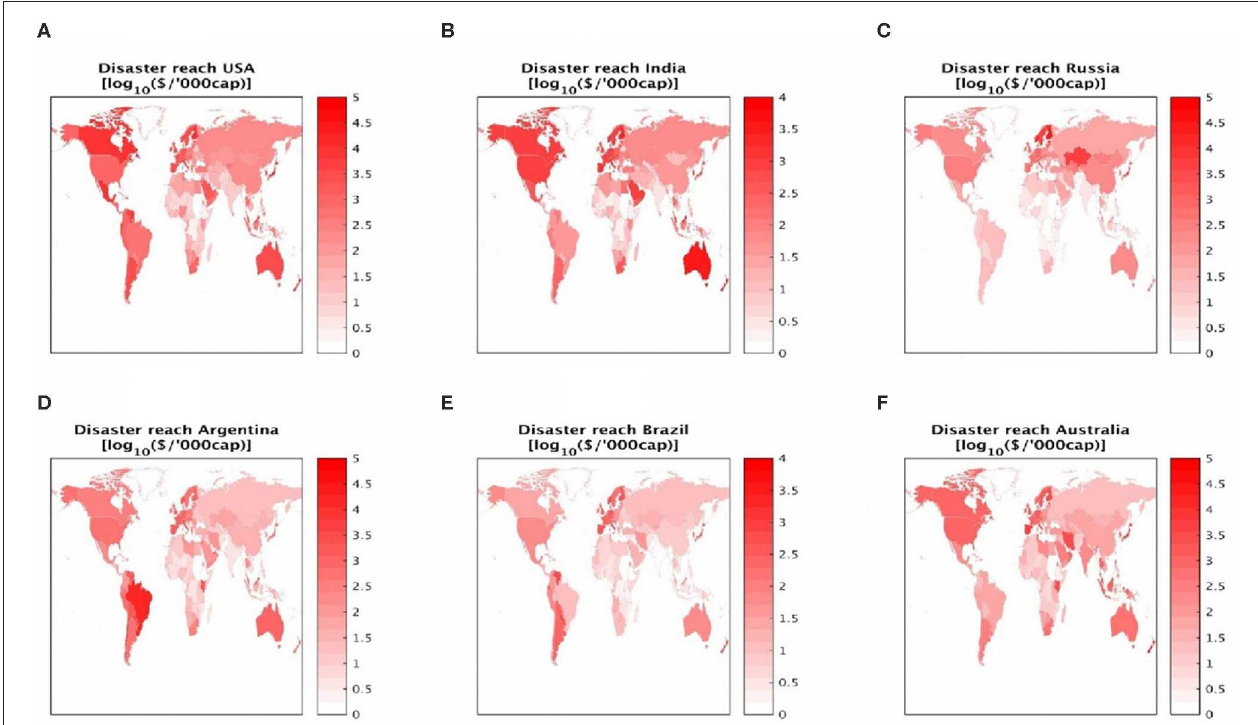
FIGURE 4 | Export shortfalls and global production. Decrease in global production as a result of a 10% shortfall in exports of wheat, maize, rice and soybeans from six major exporters: USA (A) , India (B) , Russia (C) , Argentina (D) , Brazil (E) , Australia (F) . The decrease of 10% was chosen only to exemplify the impacts and is not based on any predicted scenarios. To relate the production losses to population size in the producing countries, the maps are color-coded in units of log 10 (US$/’000cap), so that e.g., 5 = US$100/cap.